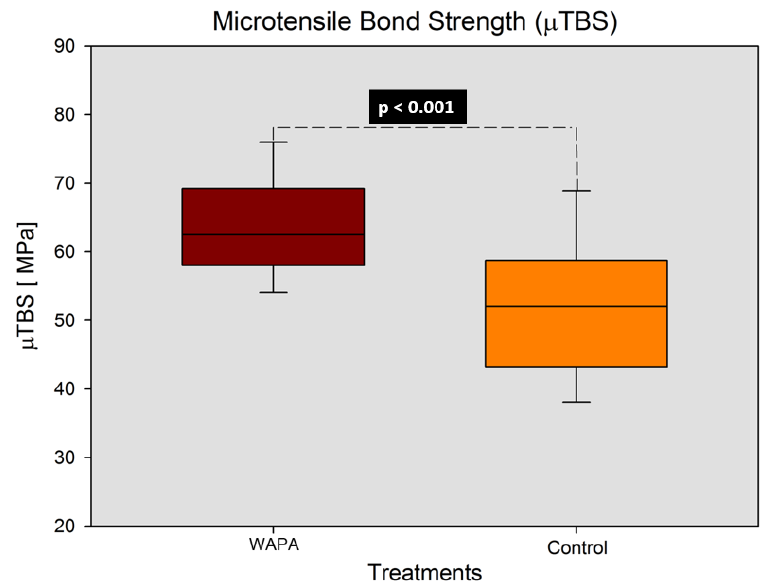
Figure 5. Results of the µ TBS of the two different treatments (WAPA and control groups). WAPA: Water–airborne-particle abrasion. Statistically significant difference ( p < 0.001) with unpaired t -test (power = 0.999 with α = 0.05).